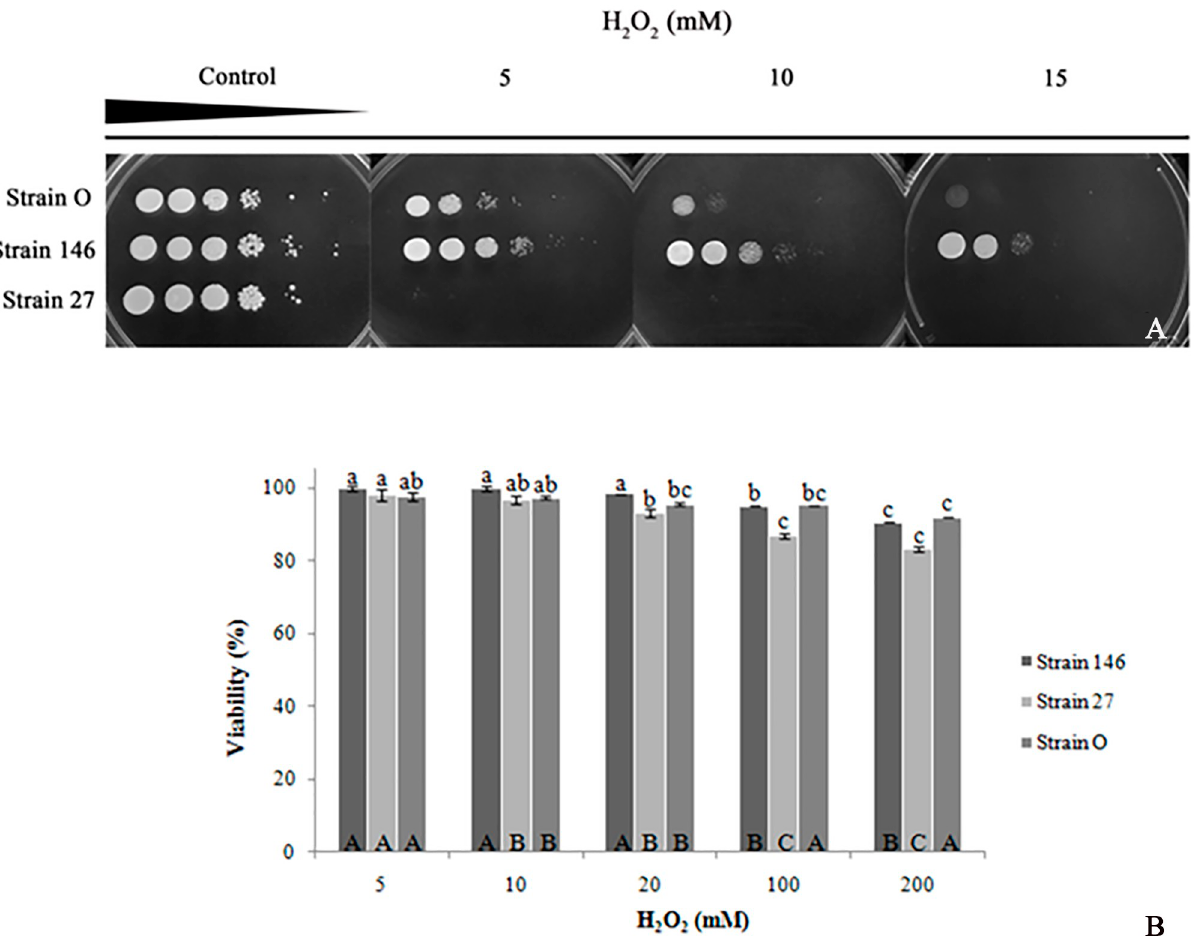
Fig 1. Impact of oxidative stress on biocontrol yeasts. (A) Liquid YEPD-cultures of C . lusitaniae 146, P . fermentans 27 and C . oleophila strain O were ten-fold serially diluted and spotted onto YEPD agar containing the above specified H 2 O 2 concentrations. Pictures were taken after 48 h at 25˚C. (B) Viability of yeast cells referred in relation to the untreated control. Yeasts were exposed to the below specified H 2 O 2 concentrations for 15 min. For details see Material and Methods 2.2.1. Mean values marked with identical letters are—according to the Tukey test (p < 0.05)—not significantly different. Lowercase letters refer to the comparison between the maltreated strains and the respective control. Uppercase letters represent the comparison between yeasts at a certain condition.